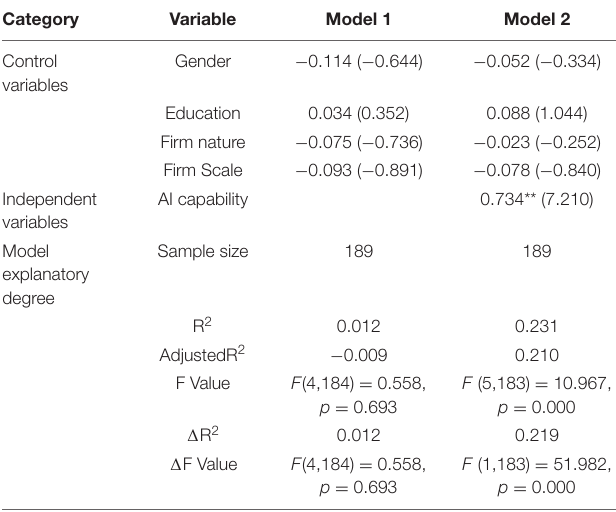
TABLE 7 | Multilevel regression test results (Explanatory variable: Organizational creativity).